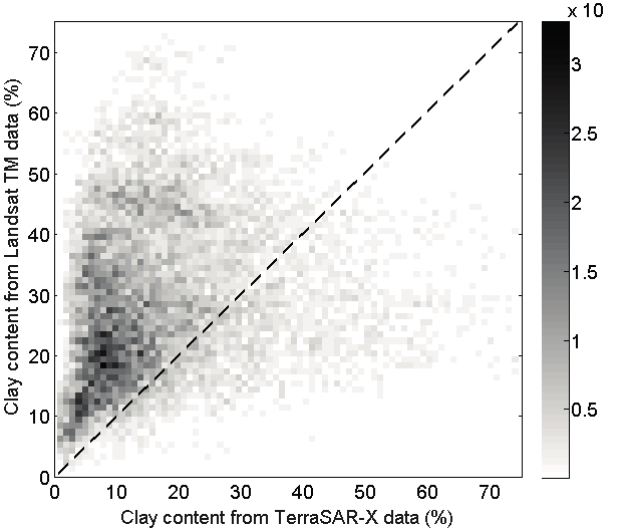
Figure 10. Density plot of clay content obtained from Landsat TM data and clay content value from TerraSAR-X radar data. The dashed line is the 1:1